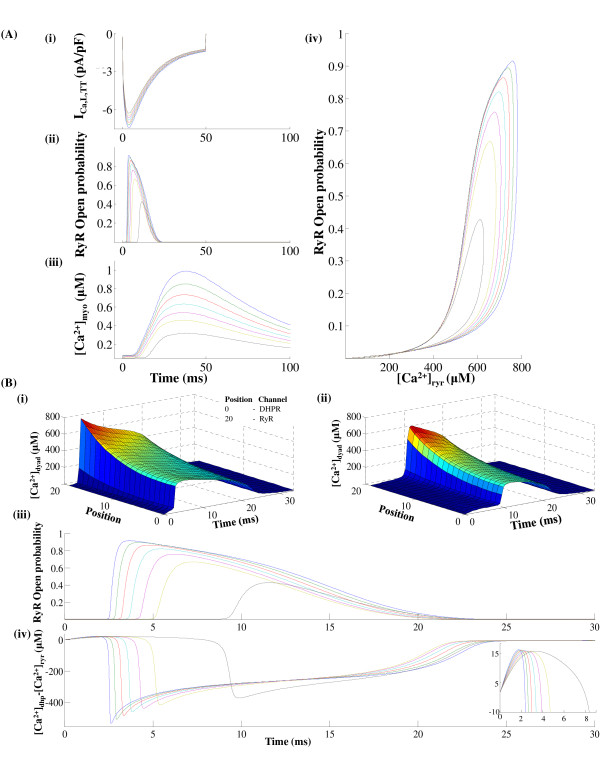
Graded CICR. Figure 10: SR calcium release graded by the trigger current ICa,L,TT . (A) - (i) Decreasing trigger current ICa,L,TT (ii) With decreasing trigger current, RyR open probability shows a graded decrease in its peak as well as an increasing delay in its onset (iii) Cytosolic calcium transient follows the trend shown by the RyR release channel (a graded decrease in peak and increasing delay in onset) (iv) RyR open probability vs [Ca2+]ryr for increasing trigger current ICa,L,TT . (B)- (i)Concentration profile in the dyad as a result of RyR release caused by a largest trigger current (see part A(i)) (ii)Concentration profile in the dyad as a result of RyR release caused by a smallest trigger current (see part A(i)) (iii) With decreasing trigger current, RyR open probability shows a graded decrease in its peak as well as an increasing delay in its onset (shown on an expanded time scale) (iv)Difference in concentration between the mouth of the DHP and Ry-sensitive Ca2+ channels. (Inset shows the cross-over when this difference becomes negative indicating trigger current dependent latency involved in release).